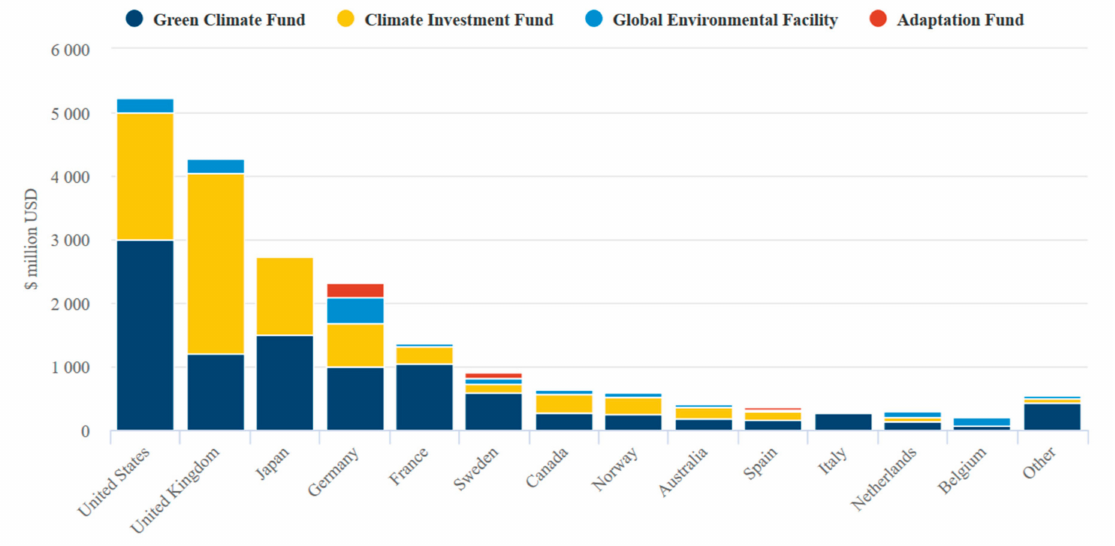
Figure 2. Leading donors’ multilateral climate funds from 2015 to May 2018 (Carbonbrief 2017; Green climate fund